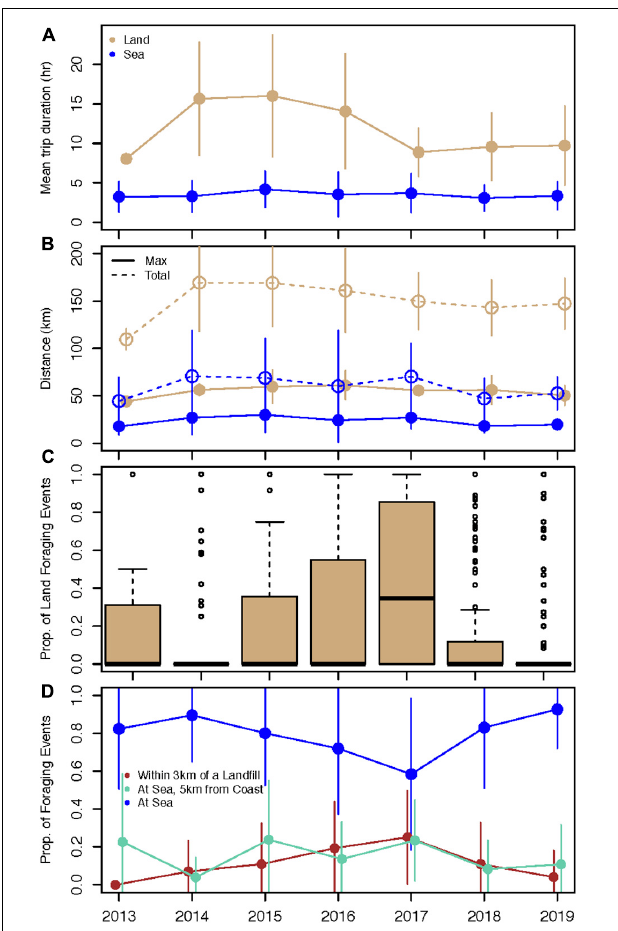
FIGURE 3 | Summary of western gull foraging trip characteristics by year. For trips where land was visited and at-sea only trips, (A) mean and standard deviation in foraging trip duration and (B) the maximum distance traveled from the colony and total distance traveled per trip. (C) Boxplot of the proportion of foraging events on land for each trip. The box represents the interquartile range, the horizontal line is the median, the whiskers represent the range of non-outlier observations, and circles are outliers. (D) The mean and standard deviation in the proportion of foraging events for each trip that were at sea, at sea and within 5 km of the shoreline, and within 3 km of a landfill/recycling